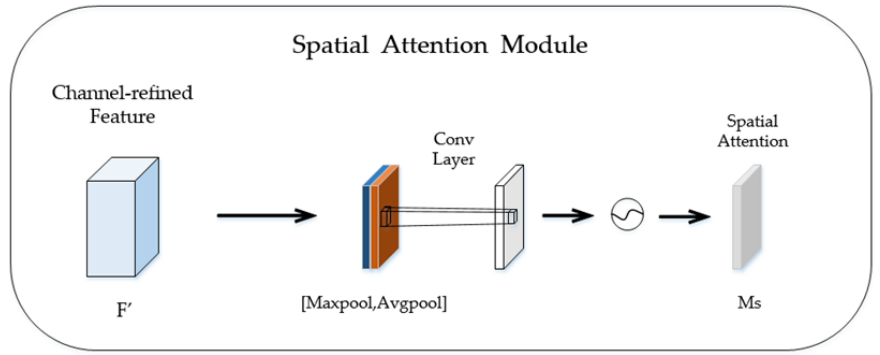
Figure 3. Spatial attention module .